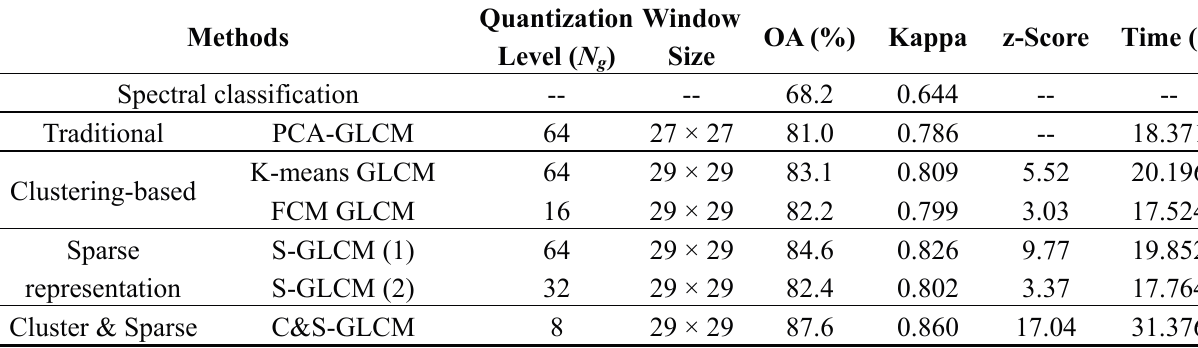
Table 11. The classification accuracies achieved by different texture extraction algorithms with the optimal parameters. The z-scores between the proposed methods and PCA-GLCM are also reported (AVIRIS Indian Pines